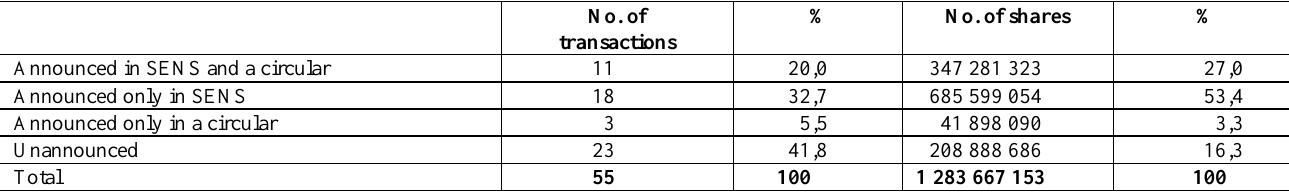
Table 2: Compliance with JSE Listing Requirements on specific repurchases